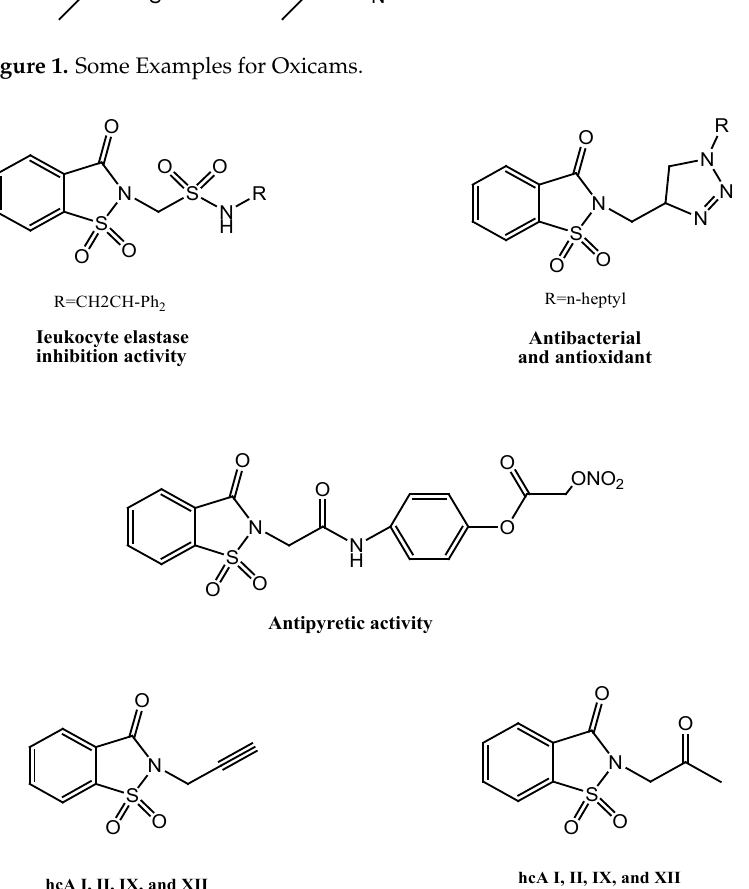
Figure 2. Structure of some N -substituted saccharins and their biological activities.